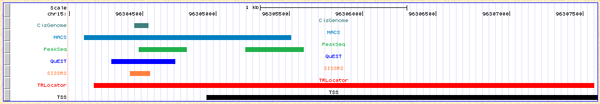
Regions of individual methods upstream of the ARRDC4 gene.